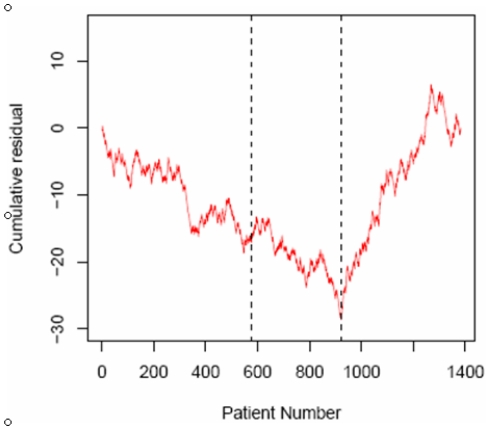
Logistic regression model comparing clinical pregnancy rates between the enclosed workstations and conventional open-fronted cabinets.Cumulative sum of residuals between observed clinical pregnancy rate and that fitted by an overall logistic regression model, plotted against time. During periods of stable performance the plot should have a constant slope: positive when performance is consistently better than average, negative for the opposite. The vertical lines mark the group boundaries. Regions with positive slopes indicate performance consistently better than average, regions with negative slopes indicate the opposite. The start of the third phase, group 3, coincides precisely with a change from a negative to positive slope and a statistically significant improvement in performance (p<0.001). There is no change in performance between the first and second phases or within any phase.